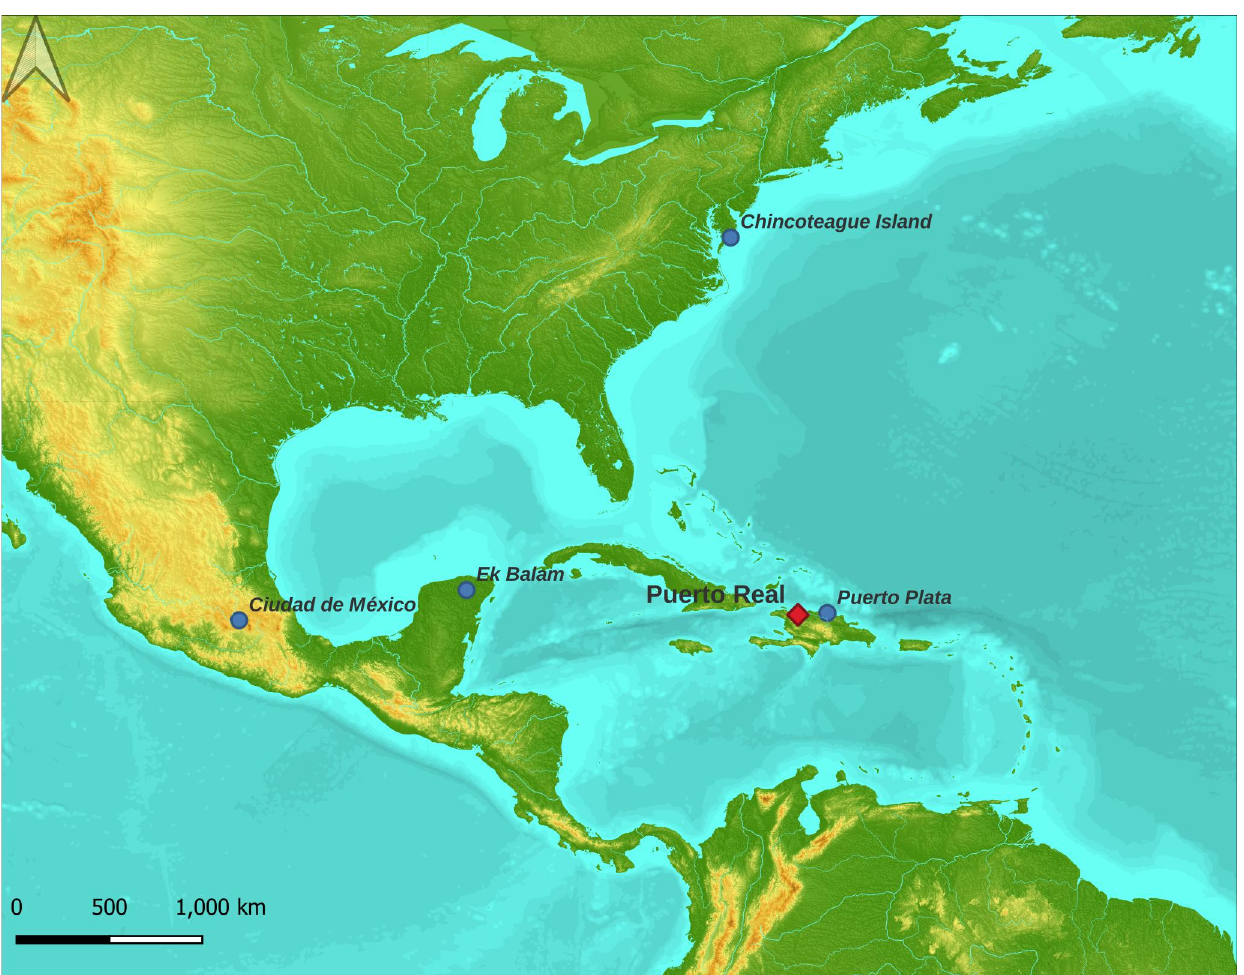
Fig 1. Location of the site of Puerto Real and other locations mentioned in the study (original map by N. Delsol, cartographic data from USGS EROS http://eros.usgs.gov/, source: NASA/METI/AIST/Japan Spacesystems and U.S./Japan ASTER Science Team).